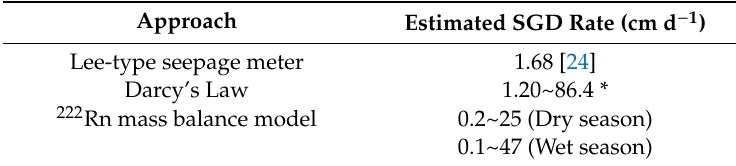
Table 3. The estimated submarine groundwater discharge (SGD) rates in the Gaomei Wetland through di ff erent